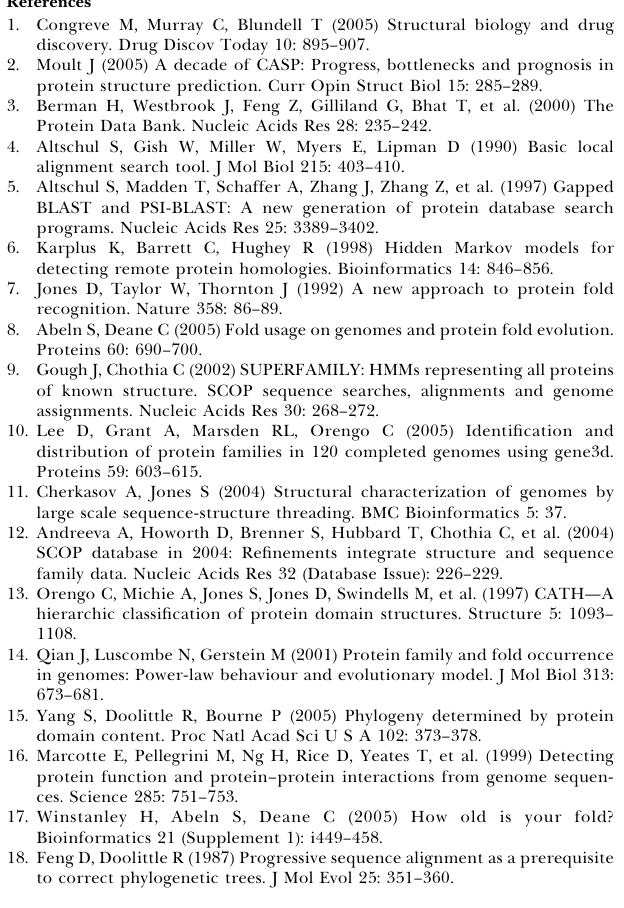
Table S1. Structural Assignments to the 150 Genomes This table shows all 150 genomes for which structural assignments are made. The keys to the genomes as used in Figure 1 are given. The coverage of structural assignments is shown for each genome by the number of genes for which at least one assignment could be made. The last column shows the number of additional copies in the SUPERFAMILY data with respect to PSI-BLAST. For the